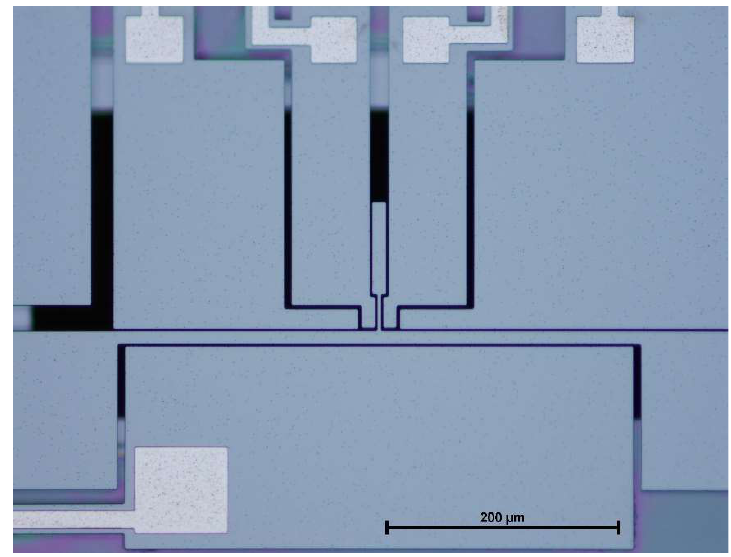
Figure 9. Fabricated device using SOIMUMPS (Silicon-on-Insulator Multi-User MEMS Processes) process.